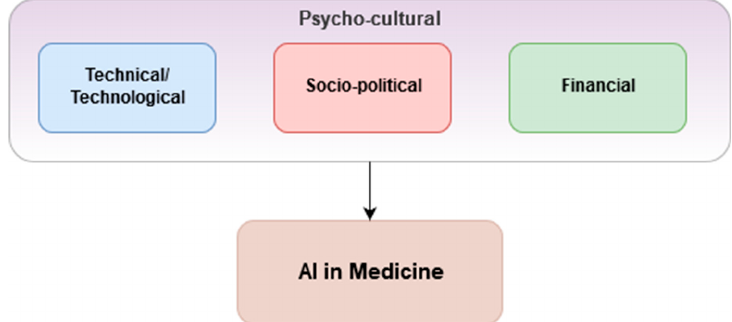
Figure 2. Four considerations for successful applications of artificial intelligence in medicine